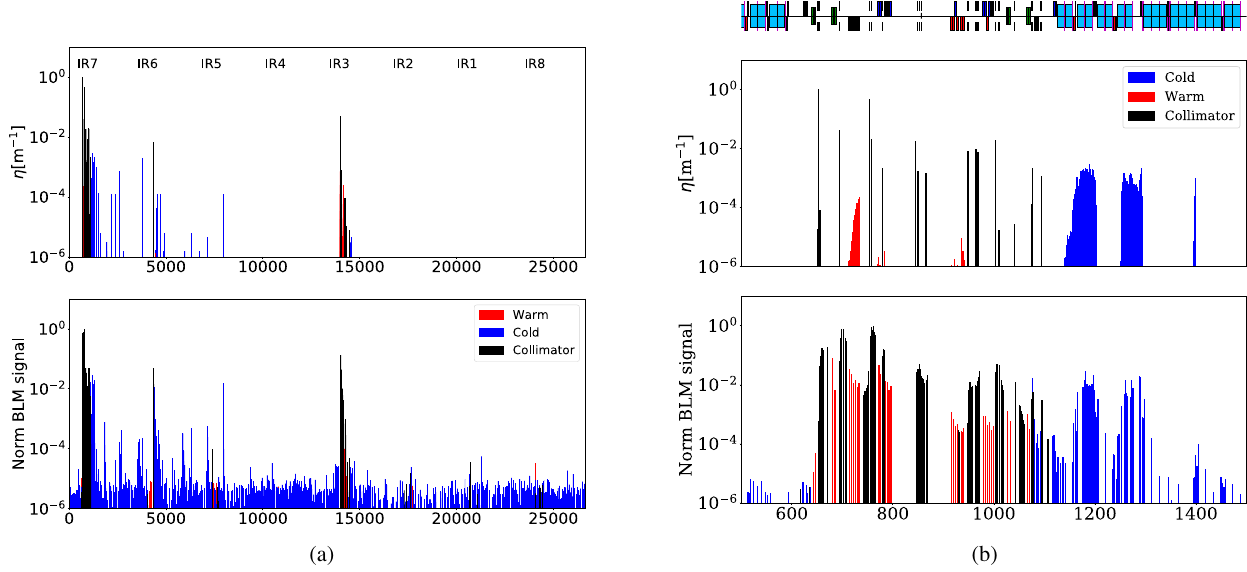
FIG. 14. Simulated (top) and measured (bottom) horizontal B2 full ring (a) and IR7 zoom (b) loss map for the 2015 208 Pb 82 þ ion beam collimation quench